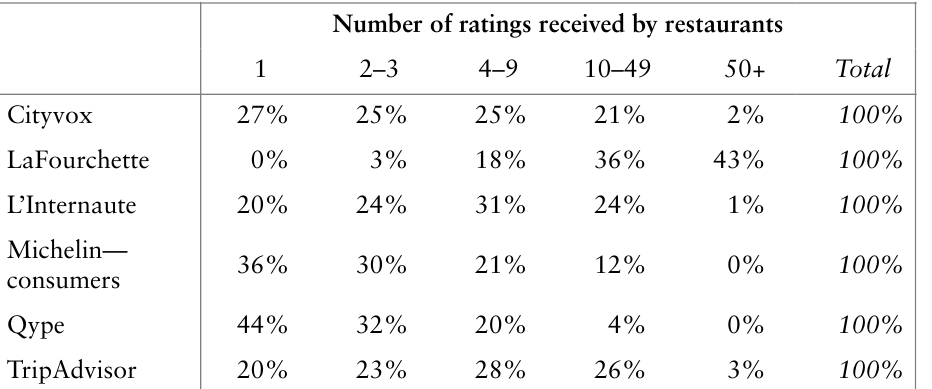
Table 6. Distribution of rating activity over restaurants. !